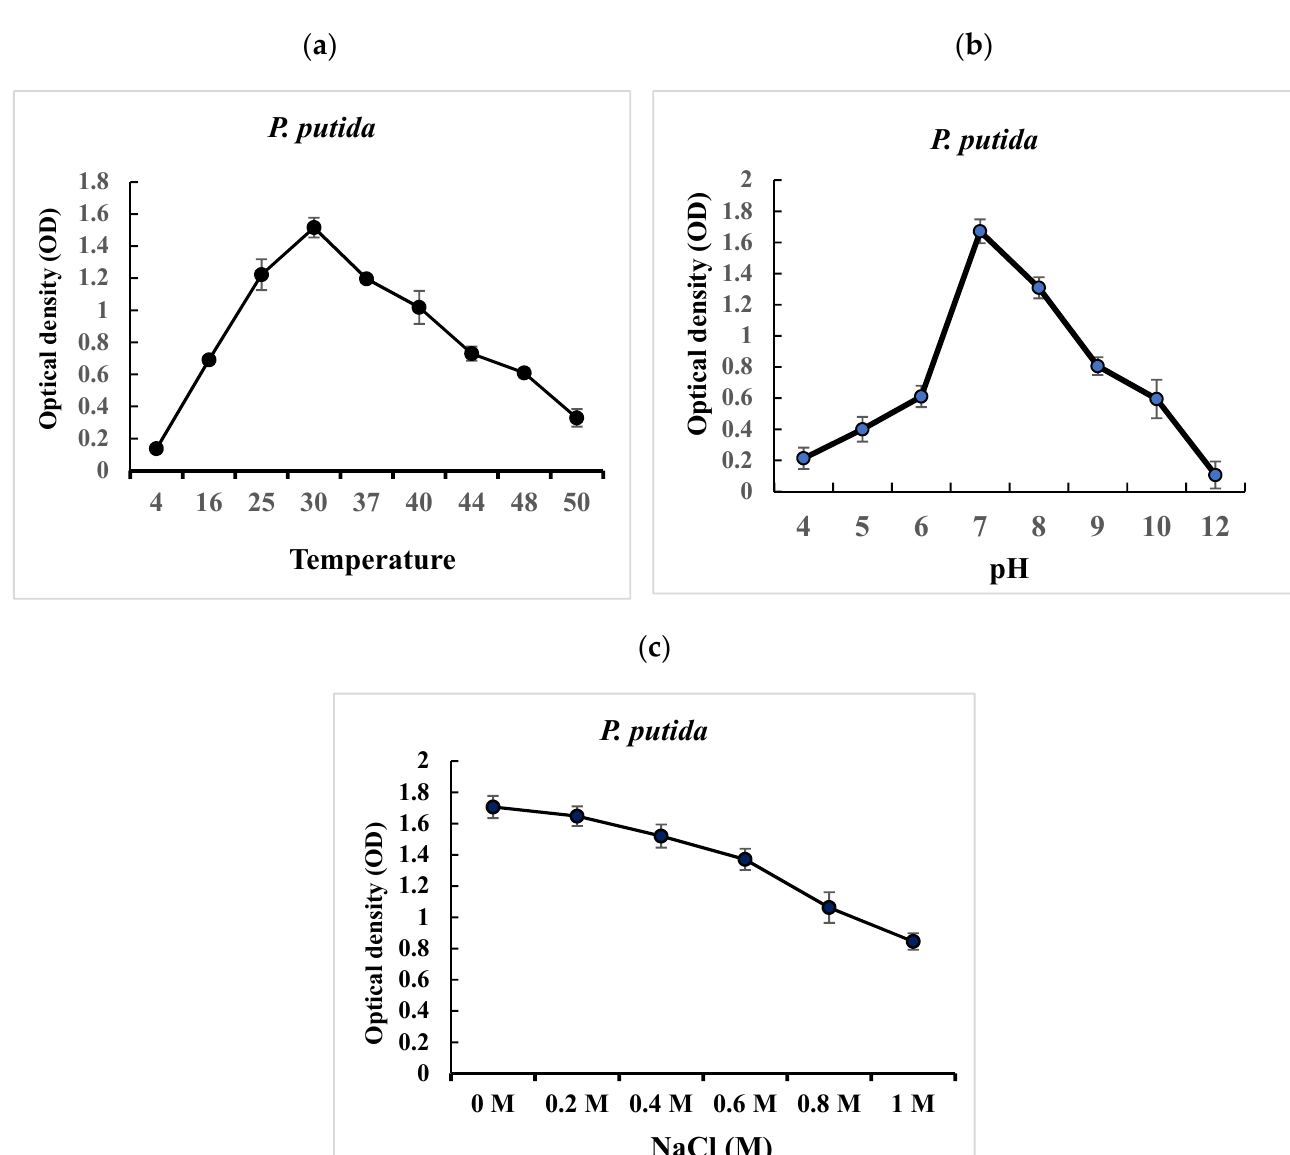
Figure 1. ( a – c ): Effect of temperature, pH, and NaCl on the growth of P. putida .